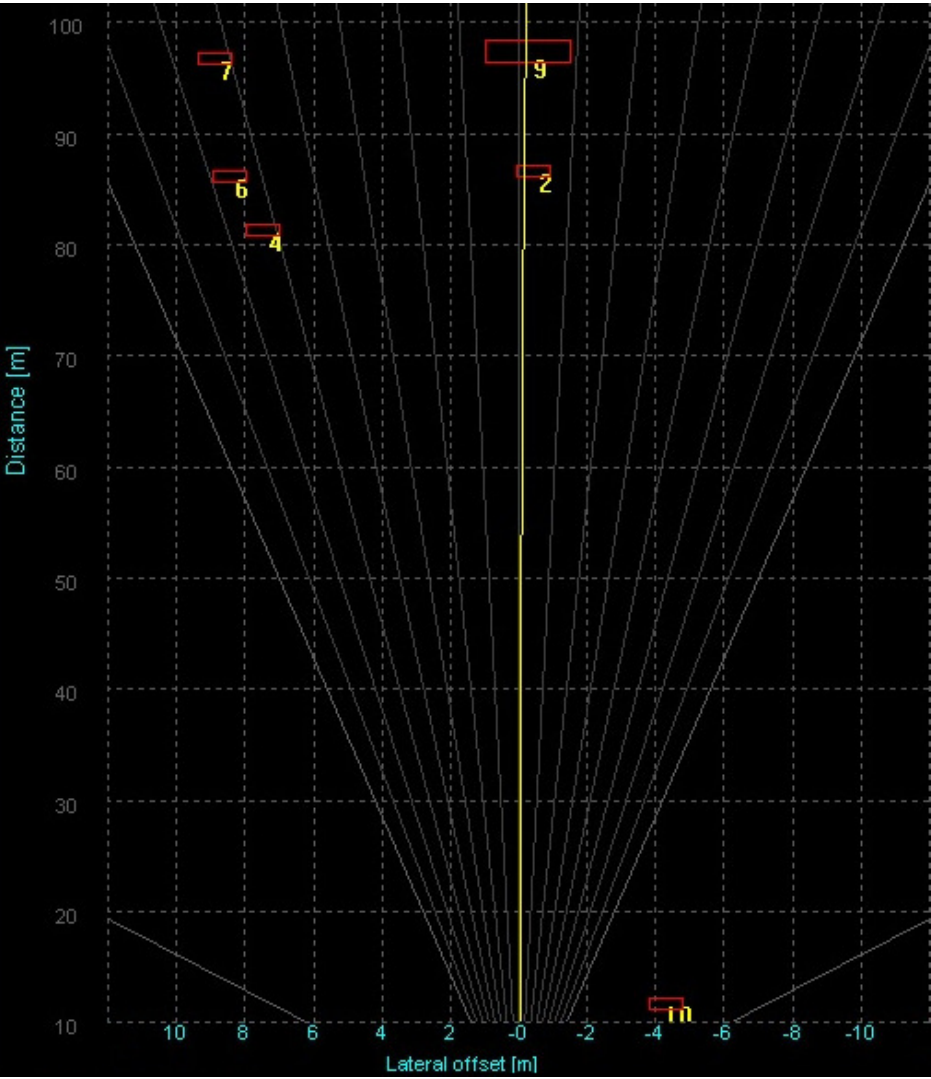
Figure 8. Output of the Continental ARS510 radar